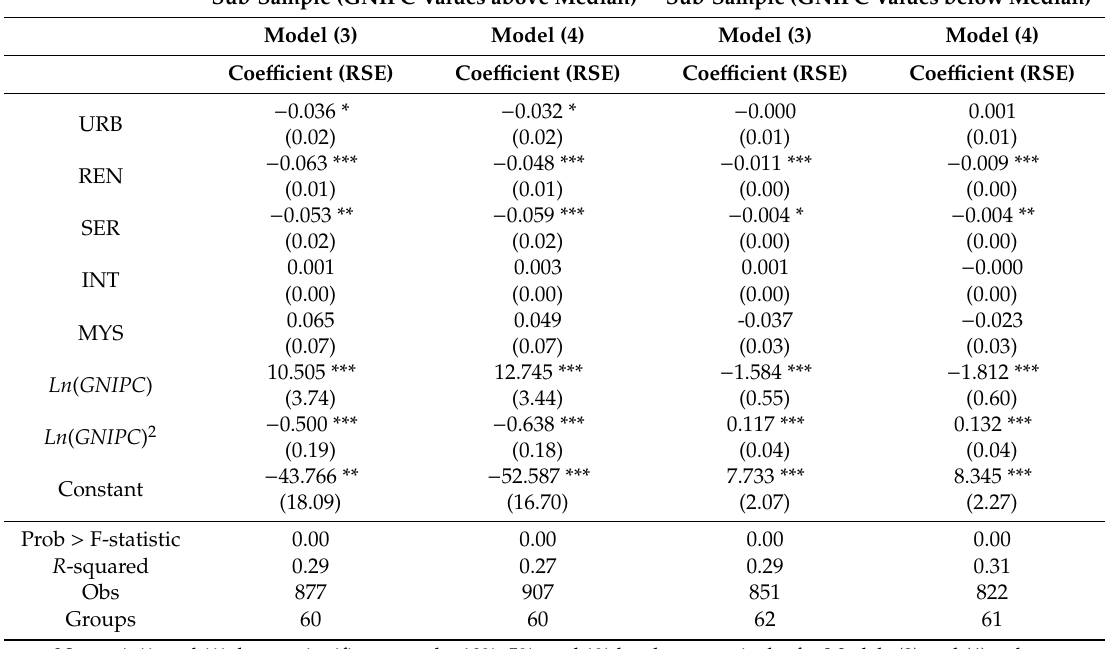
Table A1. Estimations of impacts of influencing factors and control variables for the two sub-samples (GNIPC values above / below